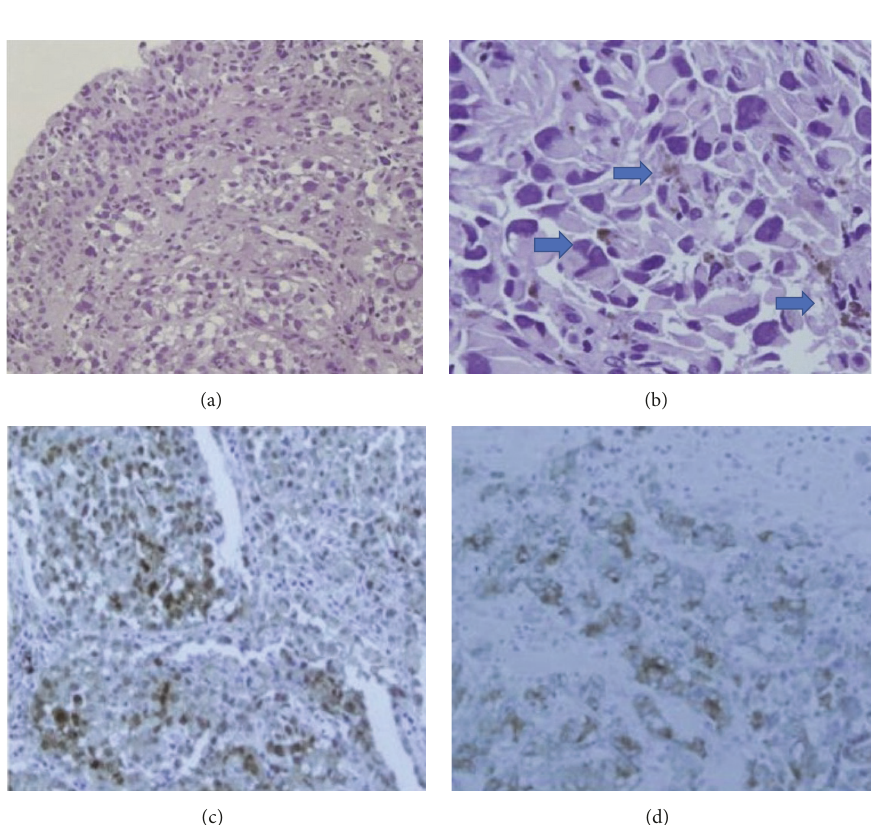
Figure 4: H&E stain ((a) 200x; (b) 400x) with tumor cells located under bronchial mucosa composed of epithelioid tumor cells with large amounts of acid cytoplasm and prominent nuclei. Mitotic figures are easily found. Note dark brown pigment in tumor cells (Arrows). Immunohistochemically, tumor cells were positive for S-100 and HBM 45 ((c) and (d)), amongst